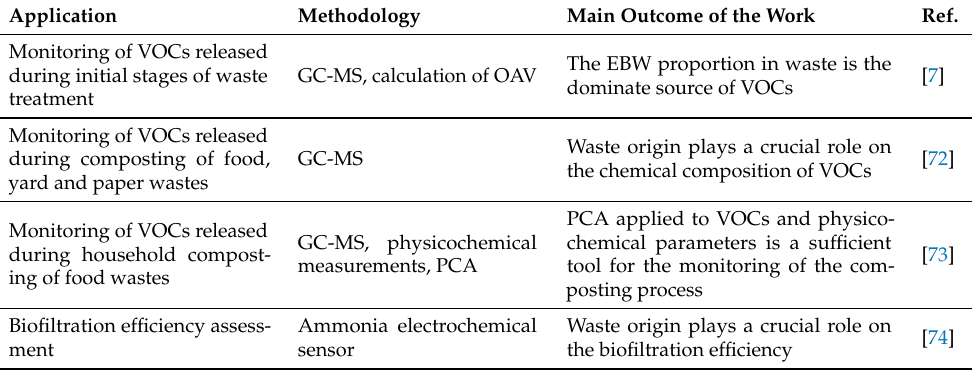
Table 4. Examples of recent applications of analytical techniques for the waste treatment pro- cesses